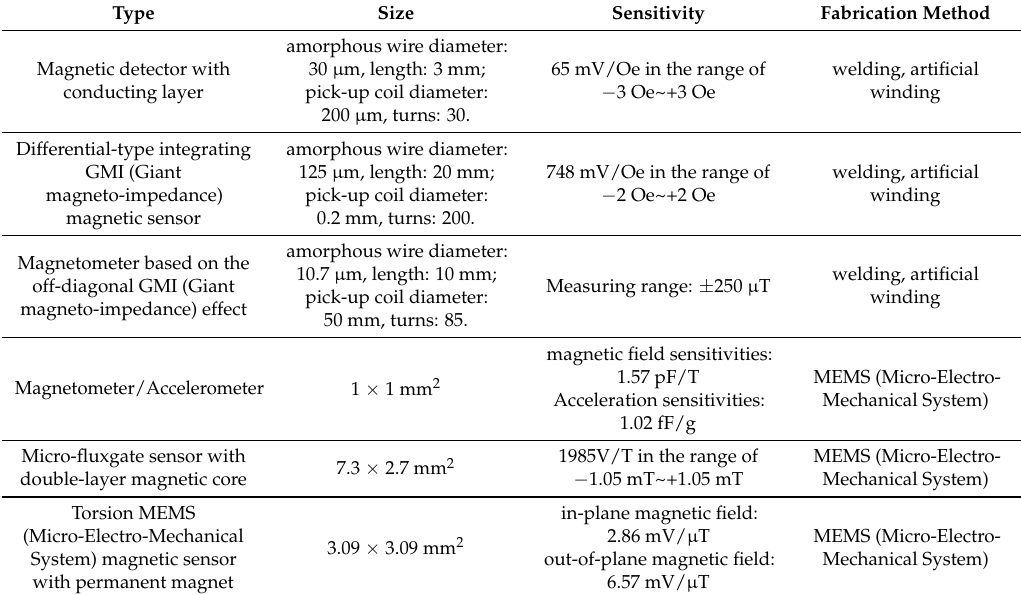
Table 1. Comparison of various magnetic